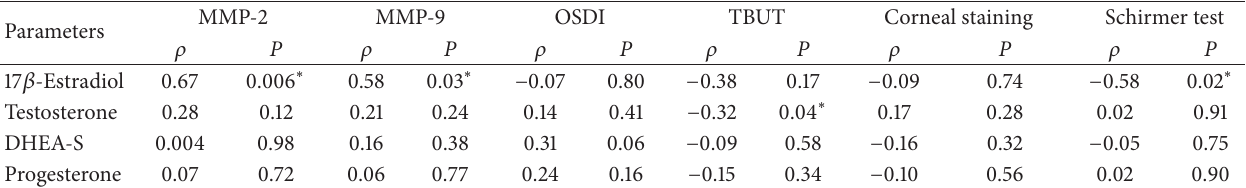
DHEA-S = dehydroepiandrosterone sulfate, MMP = matrix metalloproteinase, OSDI = Ocular Surface Disease Index, and TBUT = tear film break-up time. ∗ Significant difference with 𝑃 < 0.05